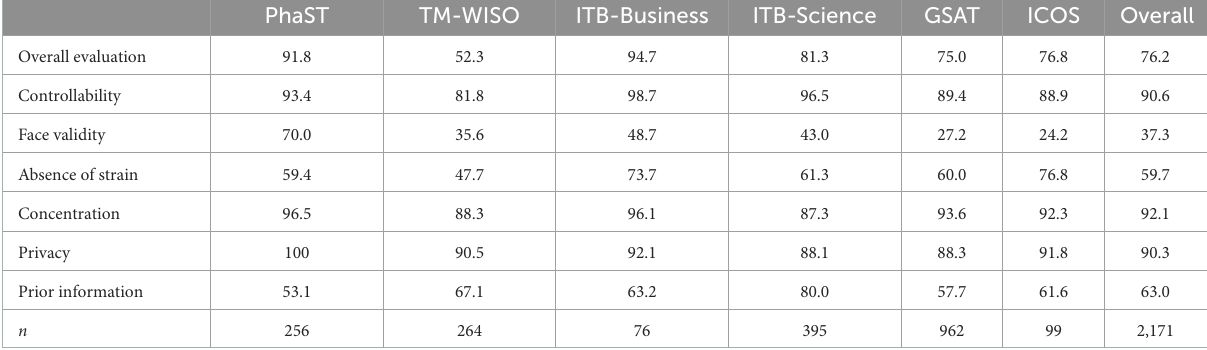
TABLE 5 Proportion of positive ratings by test. PhaST TM-WISO ITB-Business ITB-Science GSAT ICOS Overall Overall evaluation